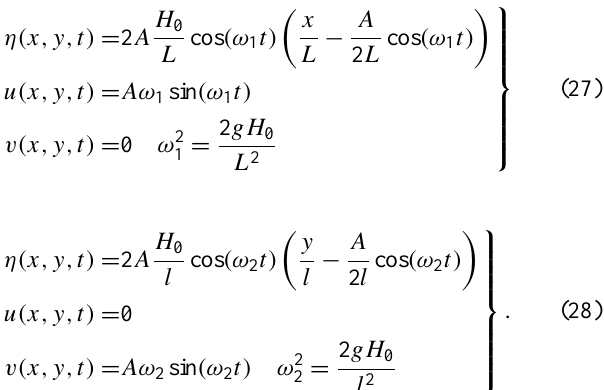
Fig. 5. Benchmark n. 1: cross sections zoomed in the shoreline area. Markers correspond to grid points at different